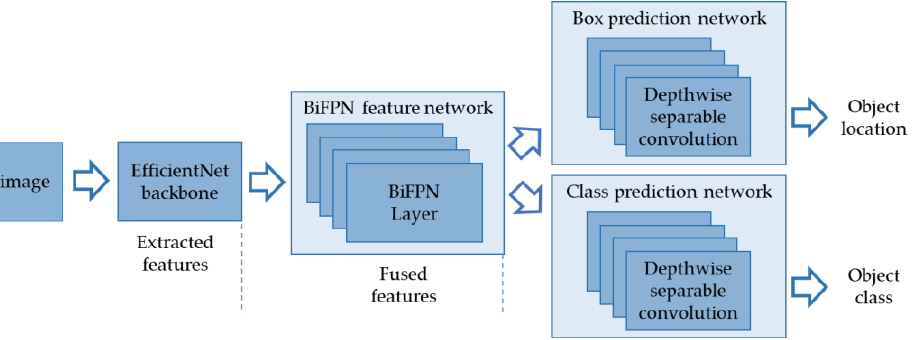
Figure 6. The structure of the EfficientDet neural network, where the number of layers changes depending on how much processing power is available [33].